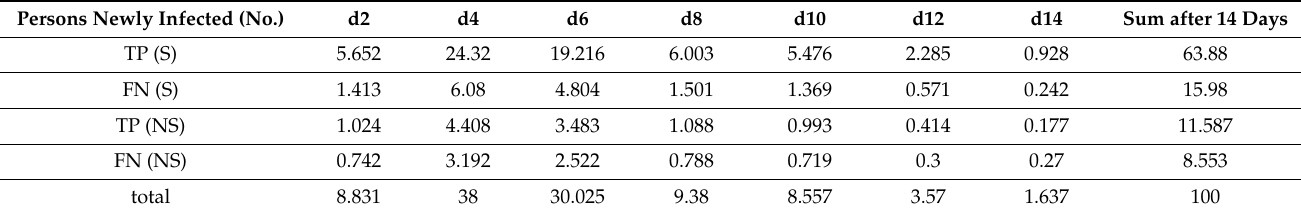
Table A3. Number and POCT results of infected HCW with and without